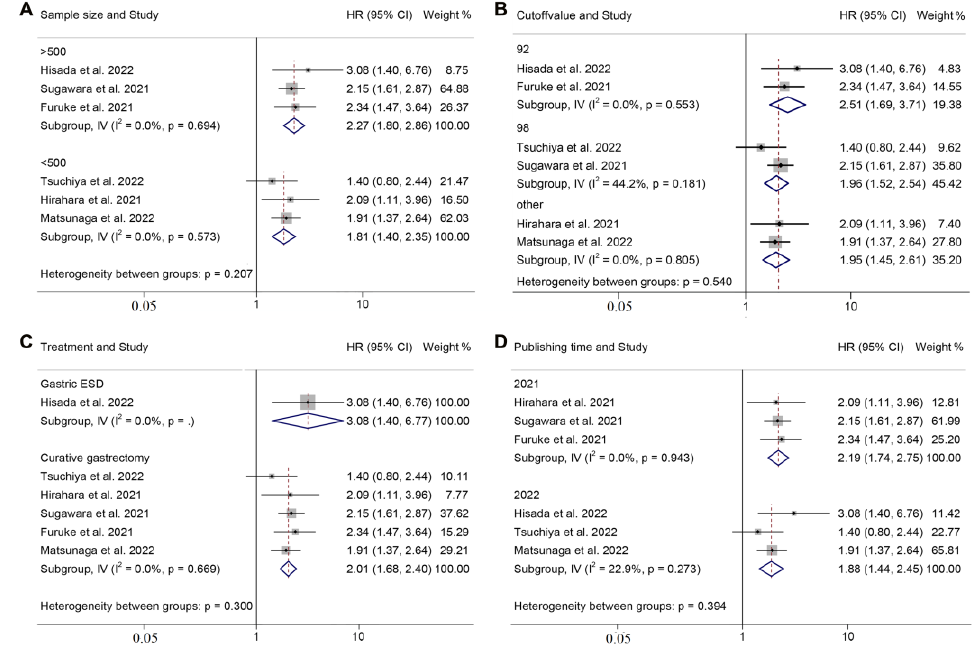
Figure 4. Subgroup analysis of overall survival based on sample size ( A ), cut-off value ( B ), treatment ( C ), and publishing year ( D ). ESD, endoscopic submucosal dissection; HR, hazard ratio; CL, confidence interval [14,16 – 21].